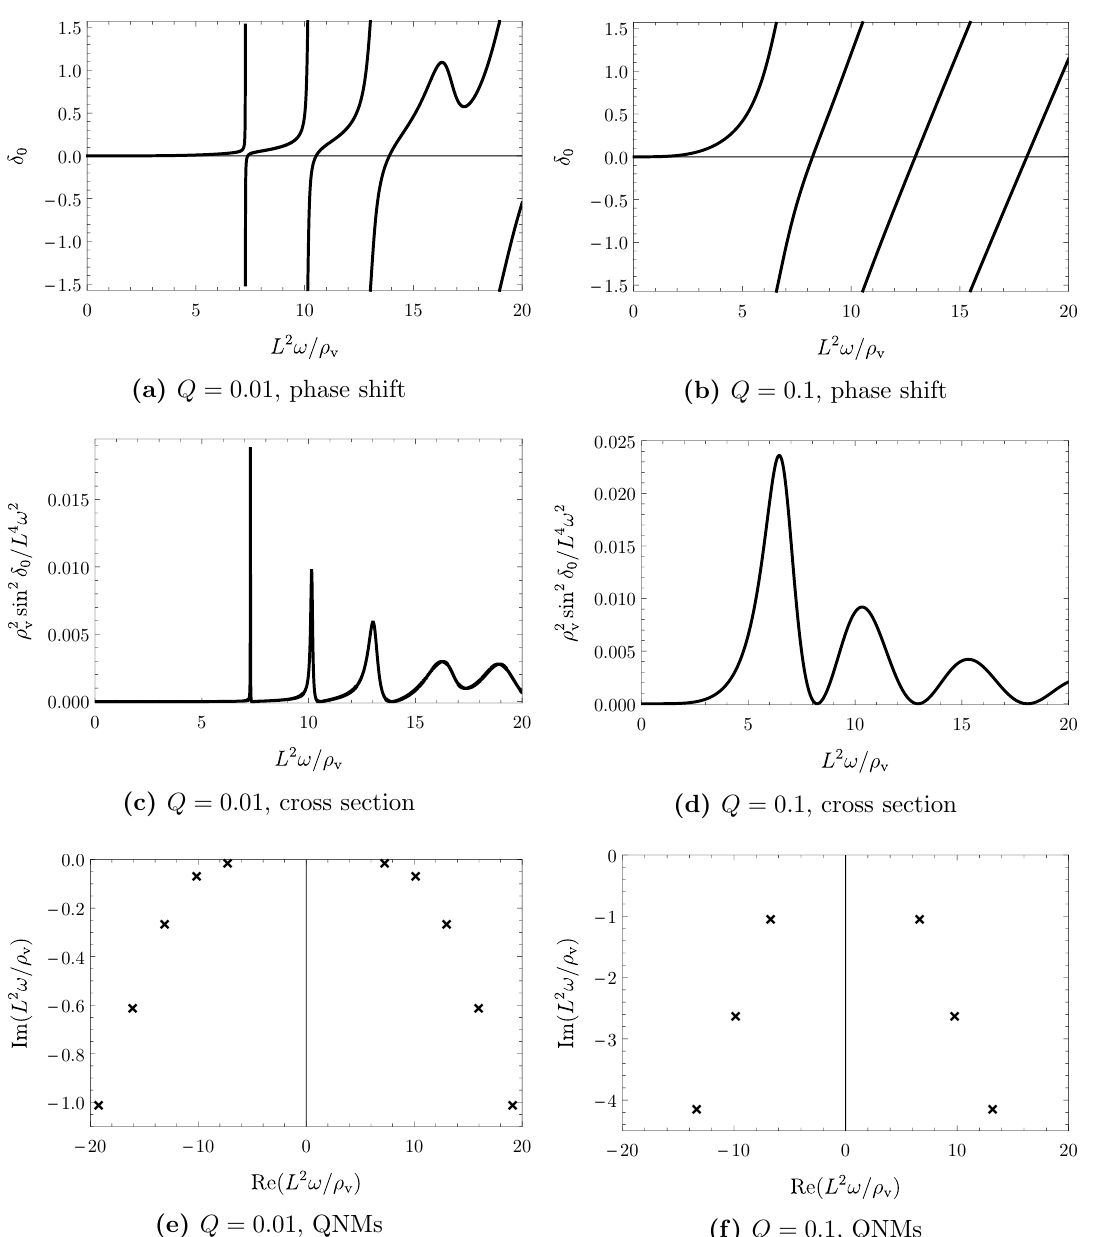
Figure 9. (a) and (b) The phase shift (cid:14) 0 for the (cid:13)uctuation (cid:26) 0 as a function of real-valued frequency ! for Q = 0 : 01 and 0 : 1. (c) and (d) The associated cross section sin 2 ( (cid:14) 0 ) =! 2 , in units of L 4 =(cid:26) 2 as a function of real-valued frequency ! , for Q = 0 : 01 and 0 : 1. (e) and (f) The complex ! plane, where black crosses denote QNMs of (cid:26) 0 , for Q = 0 : 01 and 0 : 1 (copied from (cid:12)gure 2). In all plots ! is in units of (cid:26) v =L 2 .